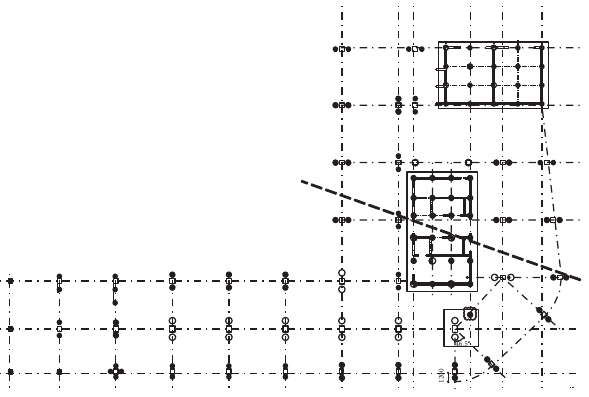
Figure 2: Pile plan of the existing engineering piles.